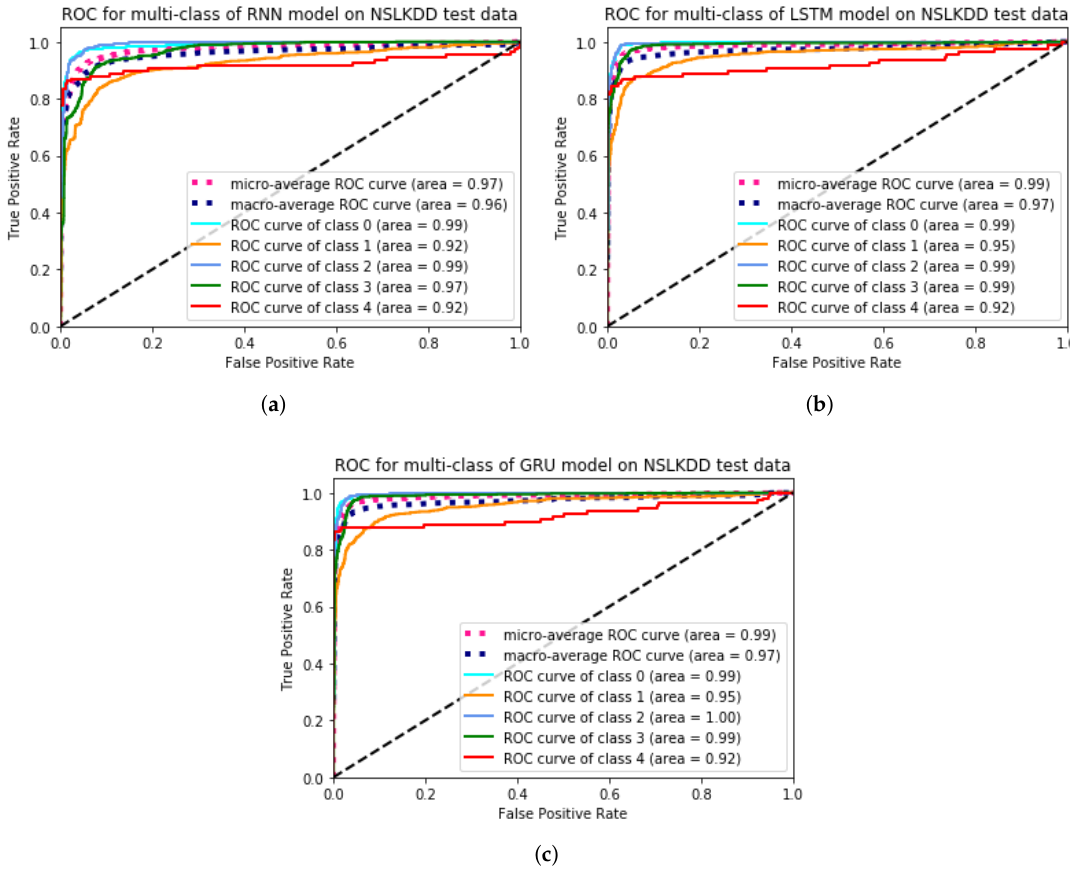
Figure 13. ROC for multi-class of three IDS models on NSL-KDD dataset. ( a ) RNN model ( b ) LSTM model ( c ) GRU model.